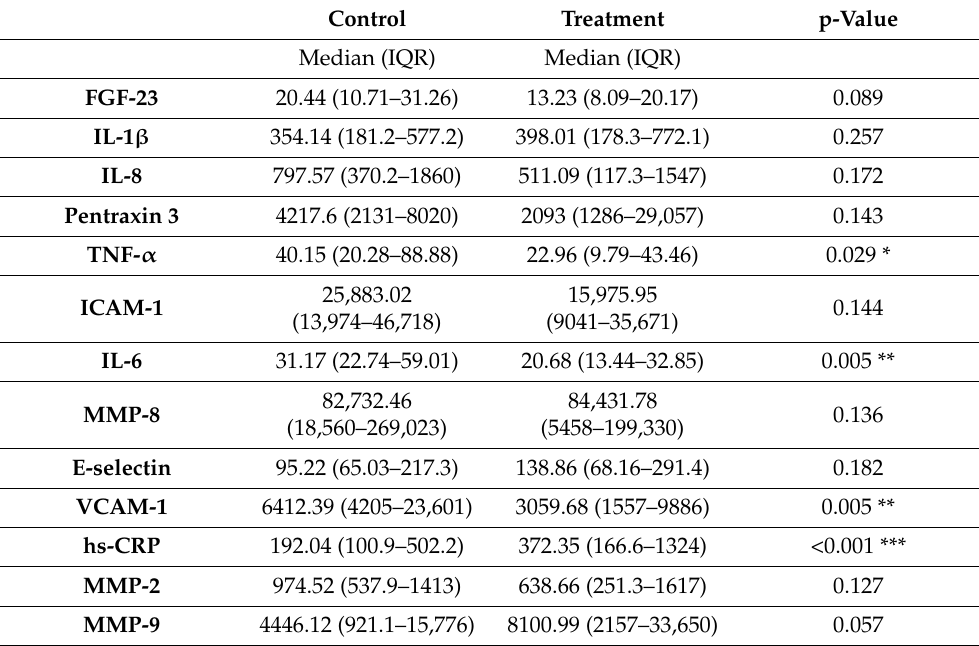
Table 2. Salivary inflammatory biomarker level comparison between control and treatment groups at